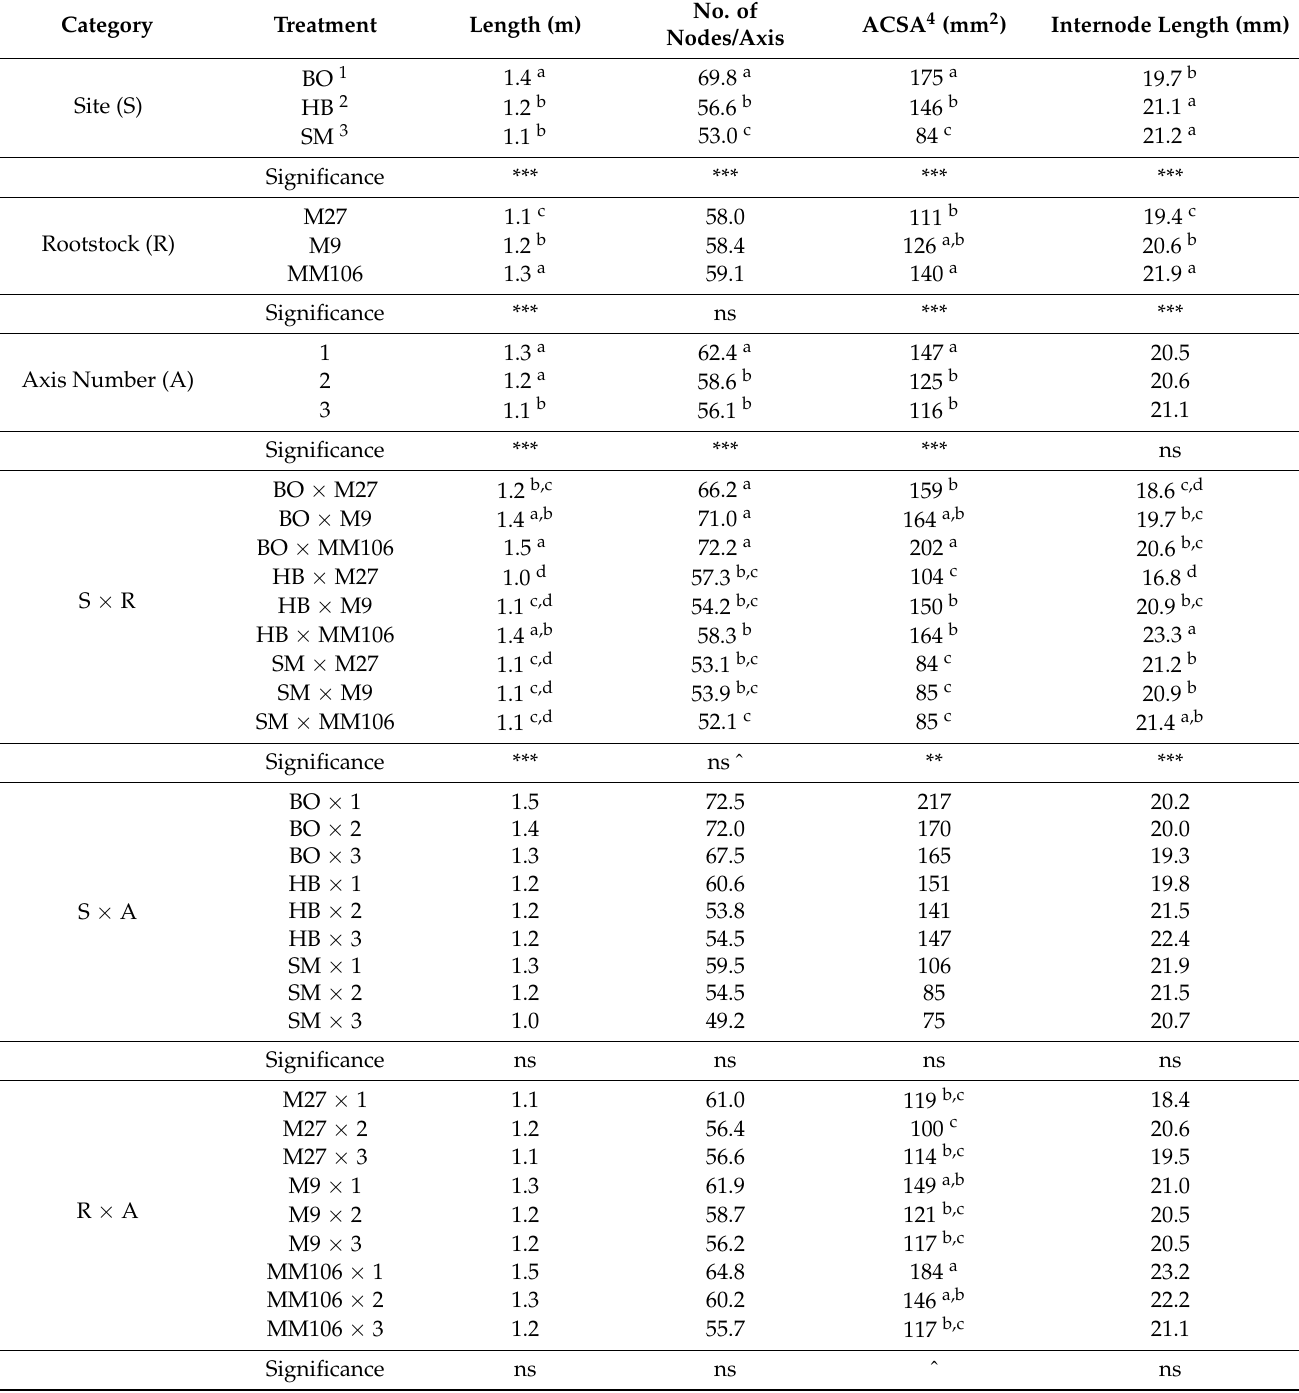
Table 4. Main effects of site of cultivation, rootstock, axis number, and their interactions on the growth attributes of the primary axis in ‘Fuji’